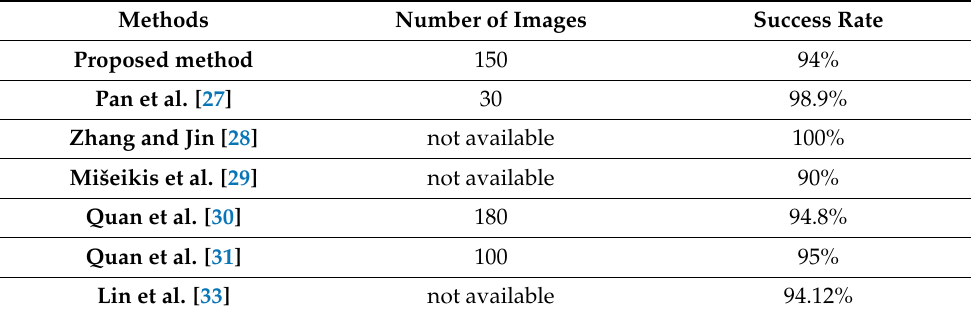
Table 3. Comparison with other